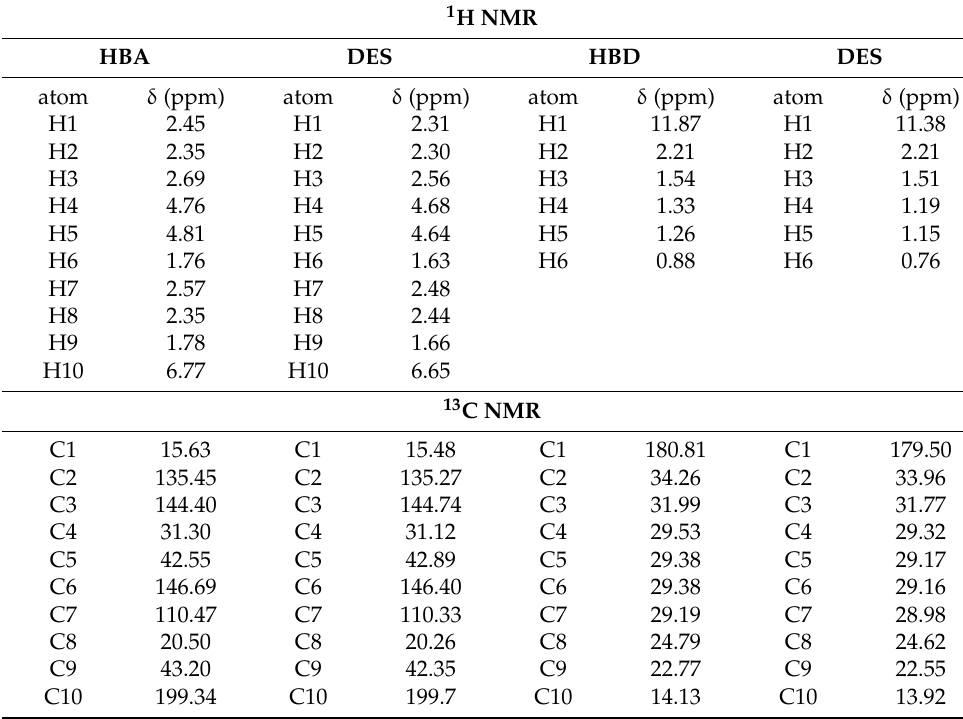
Table 1. Chemical shift values from the 1 H NMR and 13 C NMR spectra for C:DA